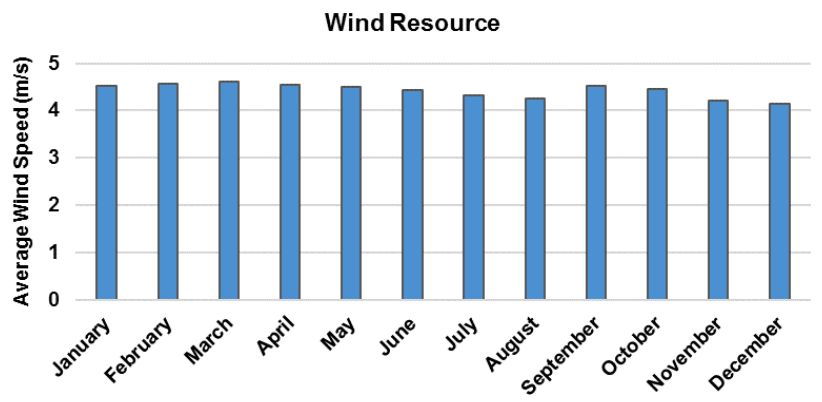
Figure 3. Monthly average wind speed in Kenya.